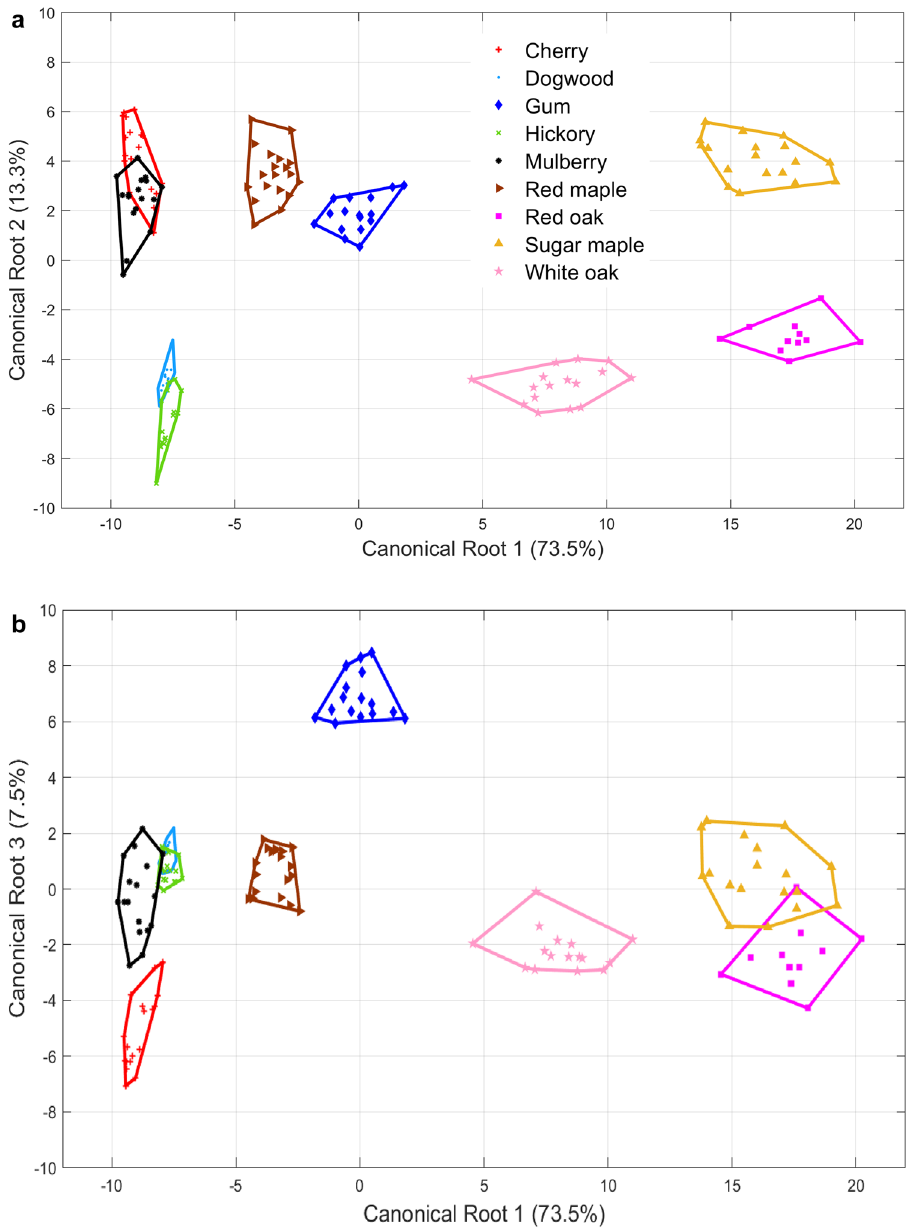
Figure 11. The 2D Canonical plots of nine genus of leaves based on 22